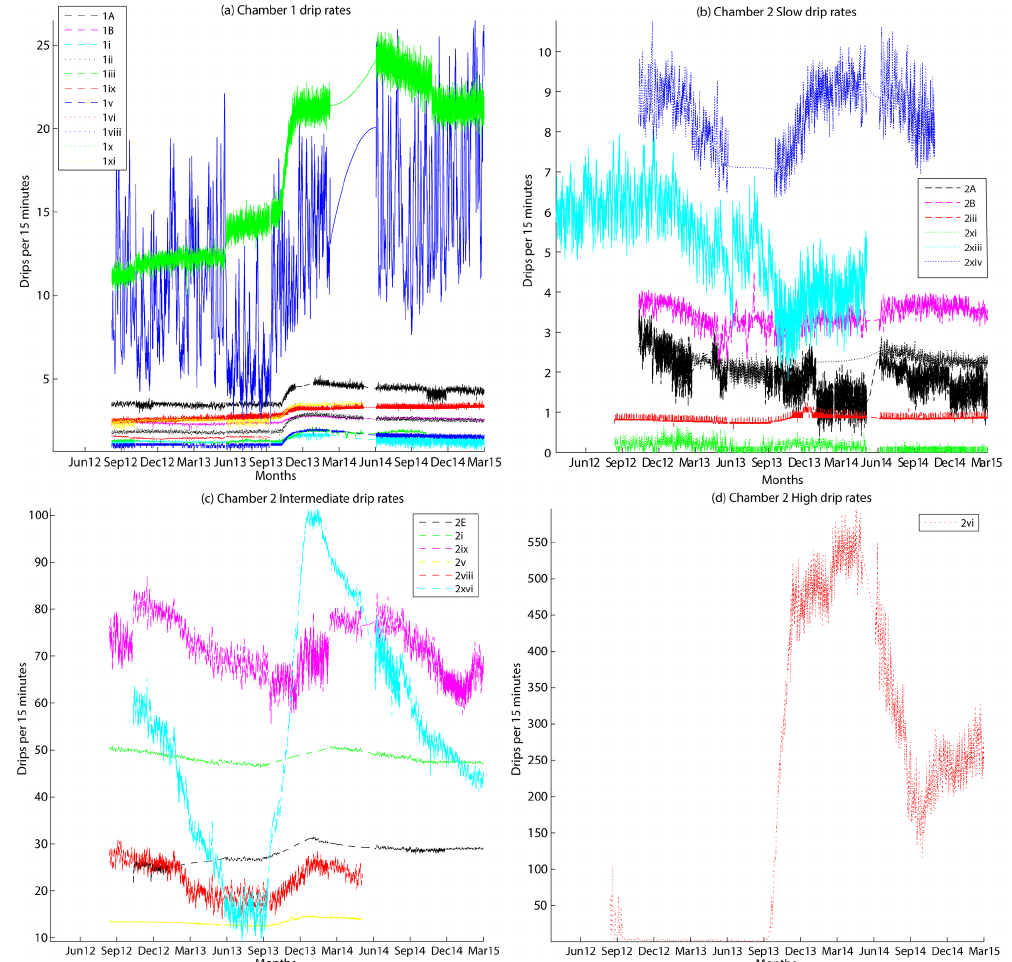
Figure 6. Both chambers’ drip rate time series for the entire monitoring period. (a) Chamber 1 drip rates. Further classification of chamber 2 drip sites for effective visualization: (b) slow flow rates with drip frequency of less than 10 per 15min, (c) medium discharges with drip frequency between 10 and 100 per 15min, and (d) fast drip rates with more than 100 drips per